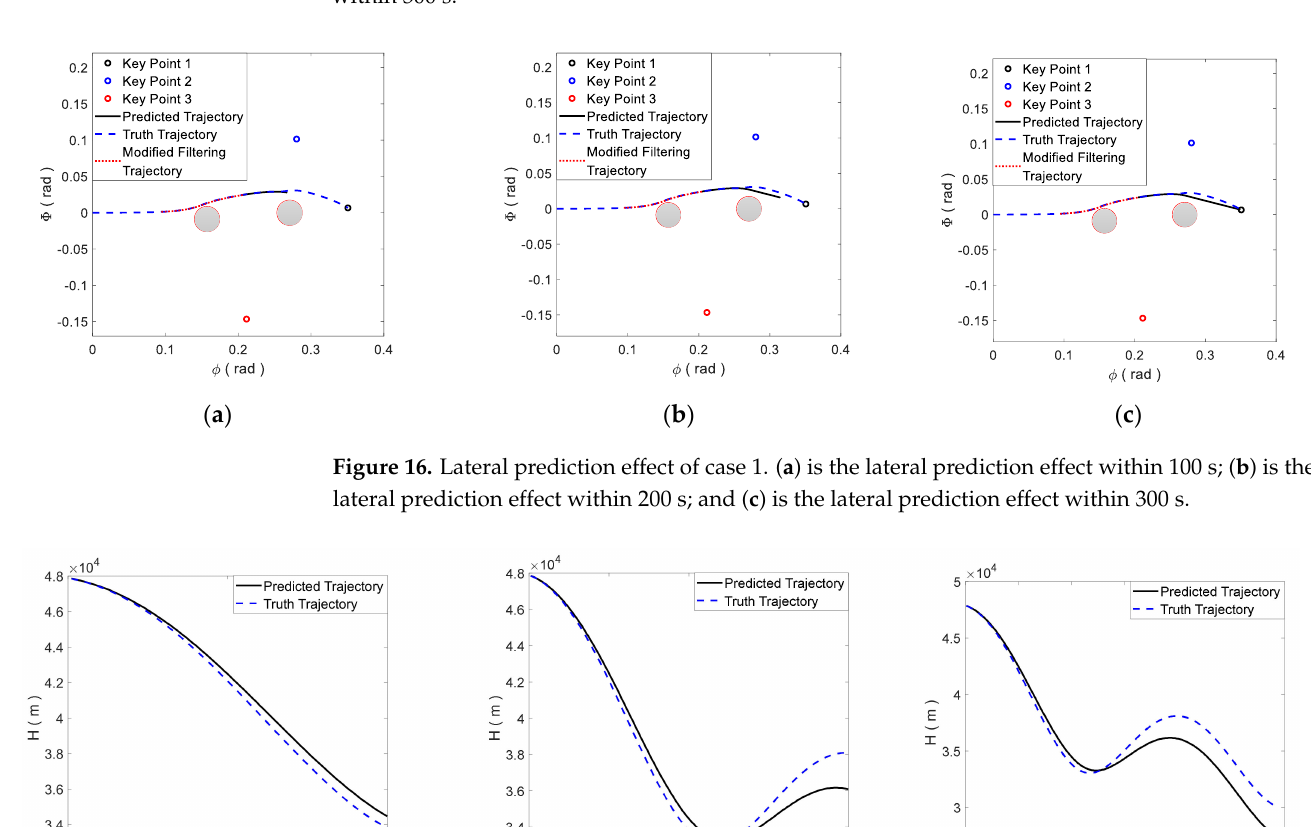
Figure 15. Longitudinal prediction effect of case 1: (a) is the longitudinal prediction effect within 100 s; (b) is the longitudinal prediction effect within 200 s; and (c) is the longitudinal prediction effect within 300 s.